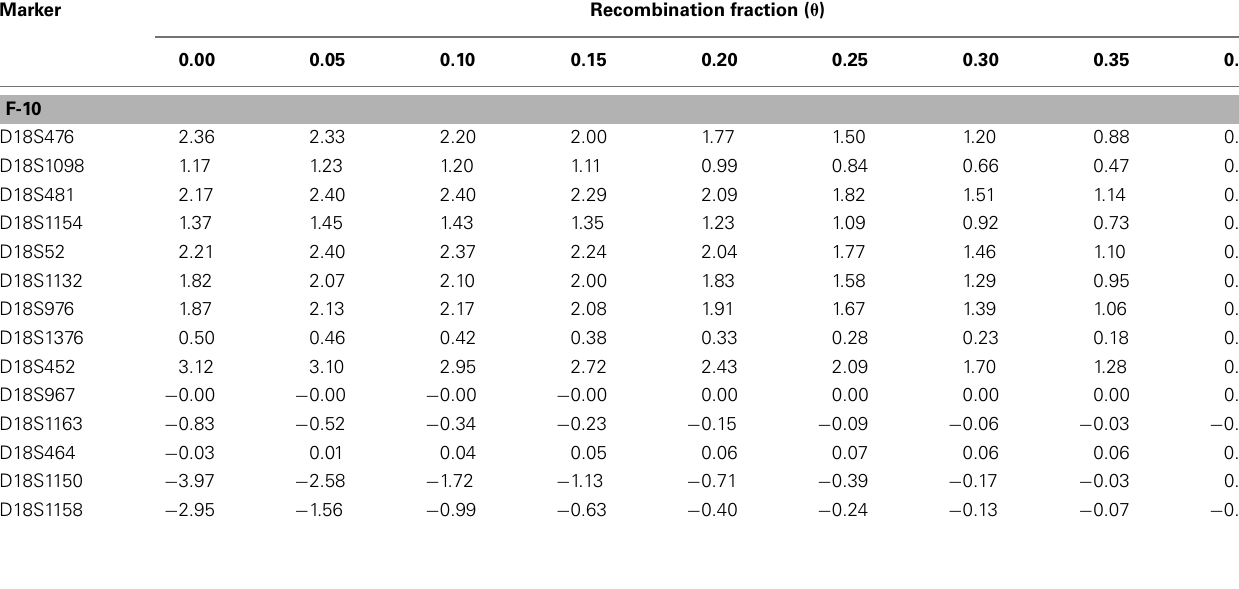
Table 1 |Two-point LOD scores for the markers genotyped in the candidate region for familial temporal lobe epilepsy in the family F-10. Marker Recombination fraction ( θ